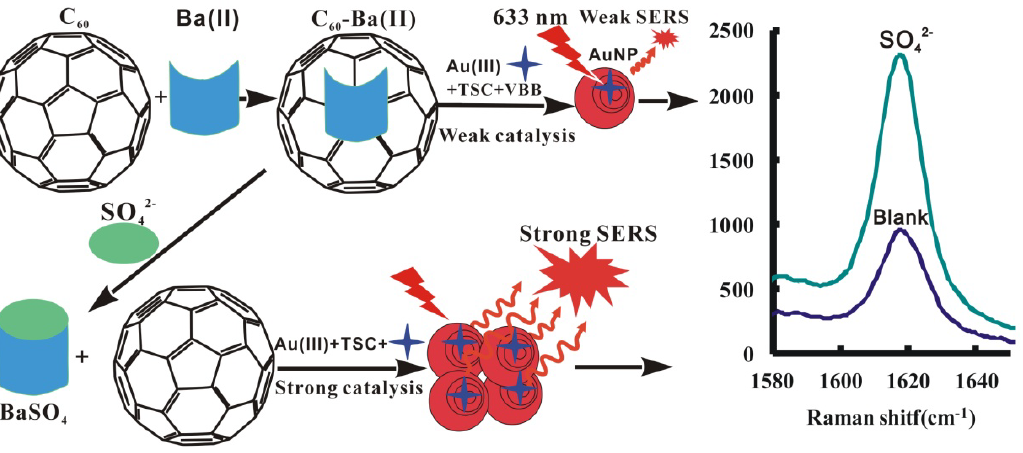
Figure 1. SERS detection of sulfate combined BaSO 4 reaction with nanogold reaction.